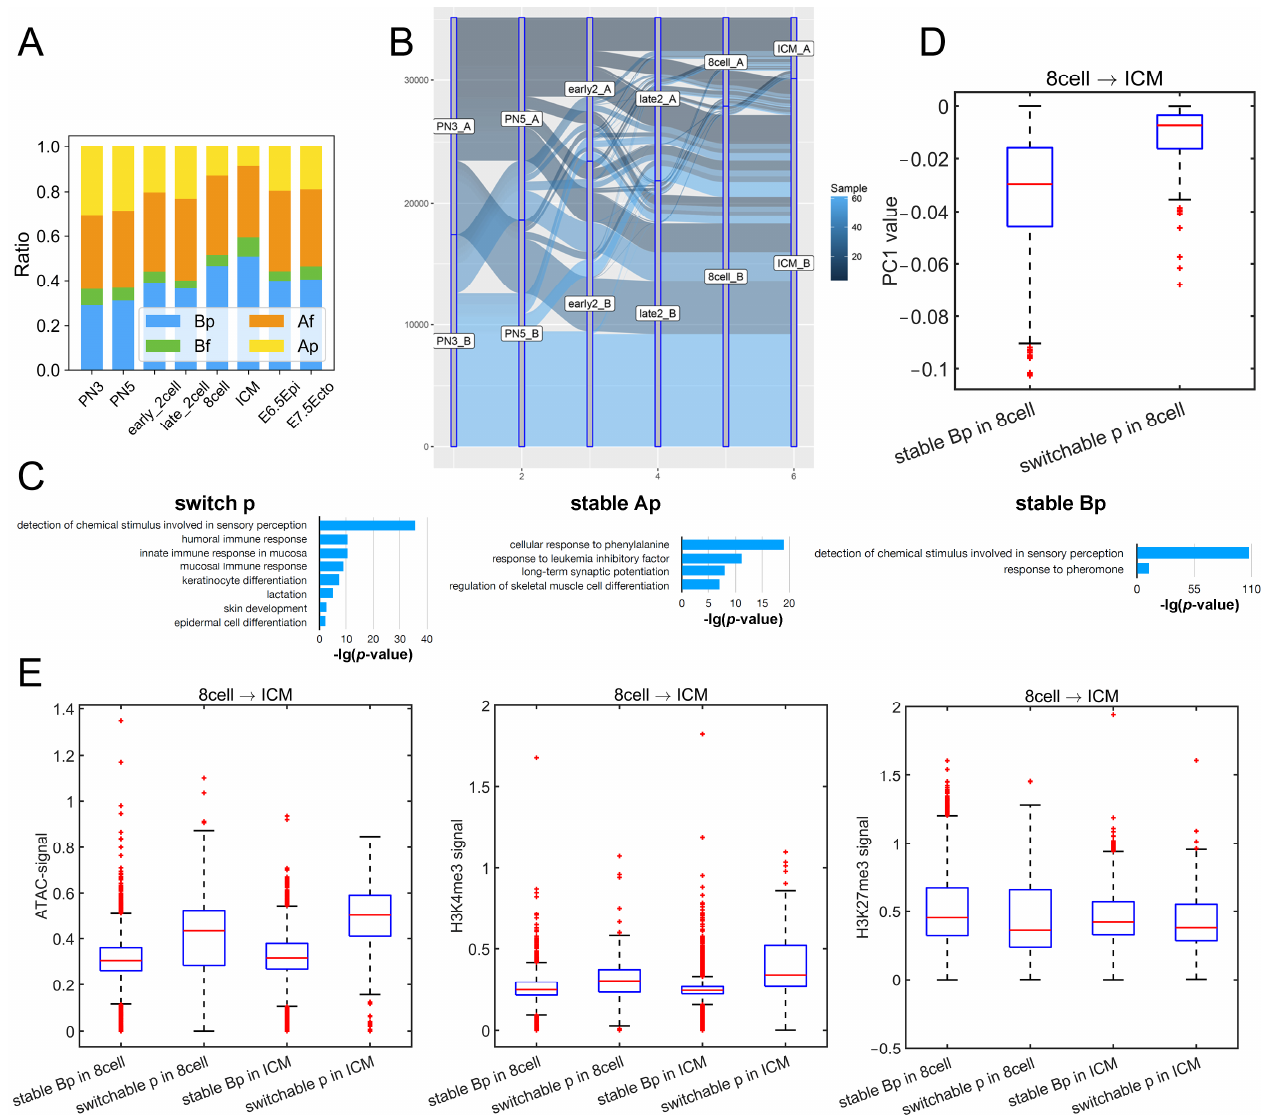
Figure 2. Compartment changes related to domain segregation. ( A ) The proportions of four sequence components, Af, Bf, Ap, Bp (calculated according to the positioning of forests and prairies in compartments A and B ), for each stage in mouse embryonic development. ( B ) The dynamic partition of prairie into compartments A and B in mouse embryonic development. ( C ) Function annotation clustering of genes located in switch p, stable Ap and stable Bp regions, respectively. ( D ) The PC1 values of stable Bp (i.e., prairie regions constantly remaining in compartment B in both 8-cell and ICM) and switchable p (i.e., prairie regions located in compartment B in 8-cell while switching to compartment A in ICM) regions in 8-cell. ( E ) From 8-cell to ICM, the ATAC-seq, H3K4me3 and H3K27me3 signals of stable Bp and switchable p regions (see notes for Figure 2 D ) in 8-cell and